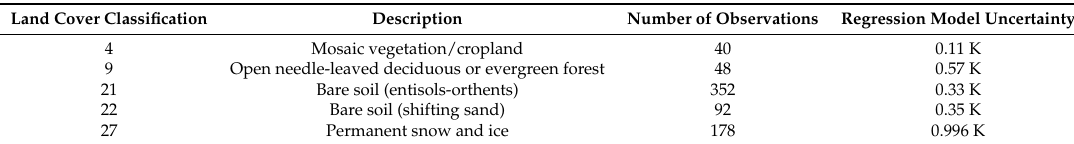
Table 3. Land cover classification numbers, descriptions, number of observations and regression model uncertainties corresponding to the data shown in Figure 10.